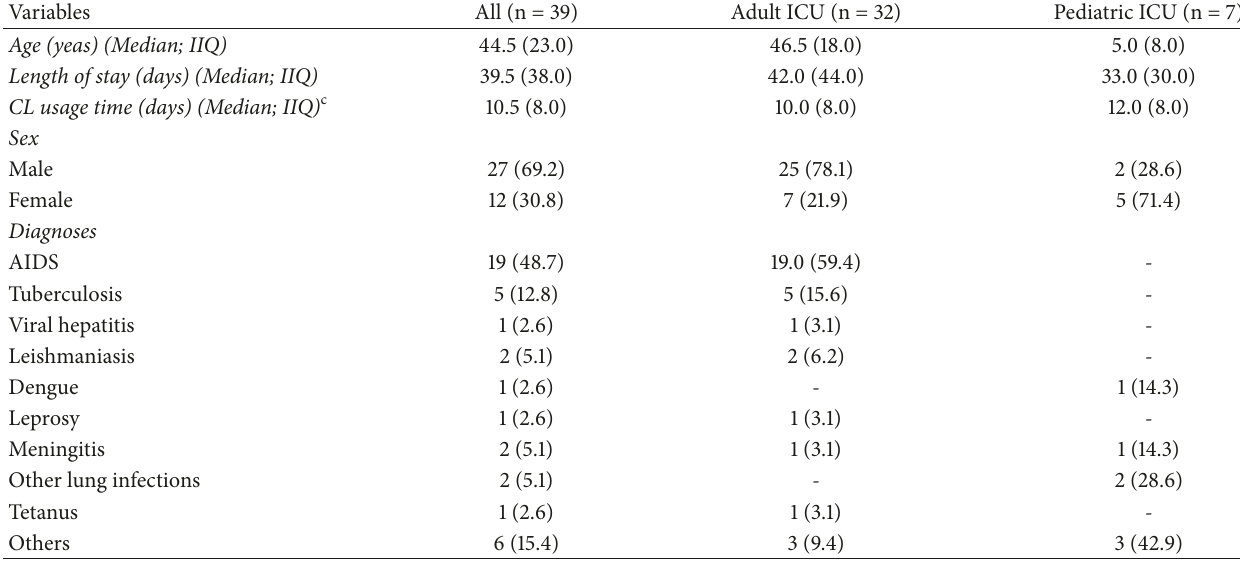
Table 4: Characterization of patients with CVC-BSIs. Central Brazil. 2012-2015.